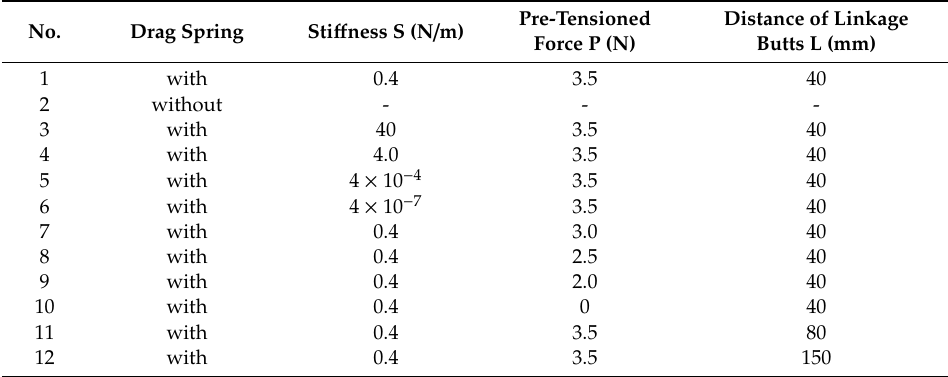
Table 3. Combinations of different parameters.